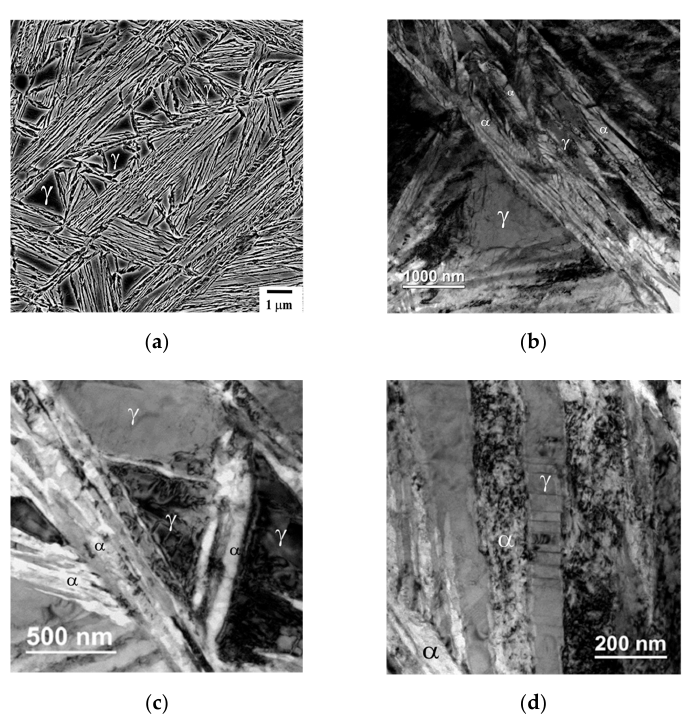
Figure 1. ( a ) SEM and ( b – d ) TEM images of bainite formed at 220 °C for 22 h in a high-carbon (1.0 wt.%) and high-silicon (2.5 wt.%) steel; α is bainitic ferrite, and γ is retained austenite.